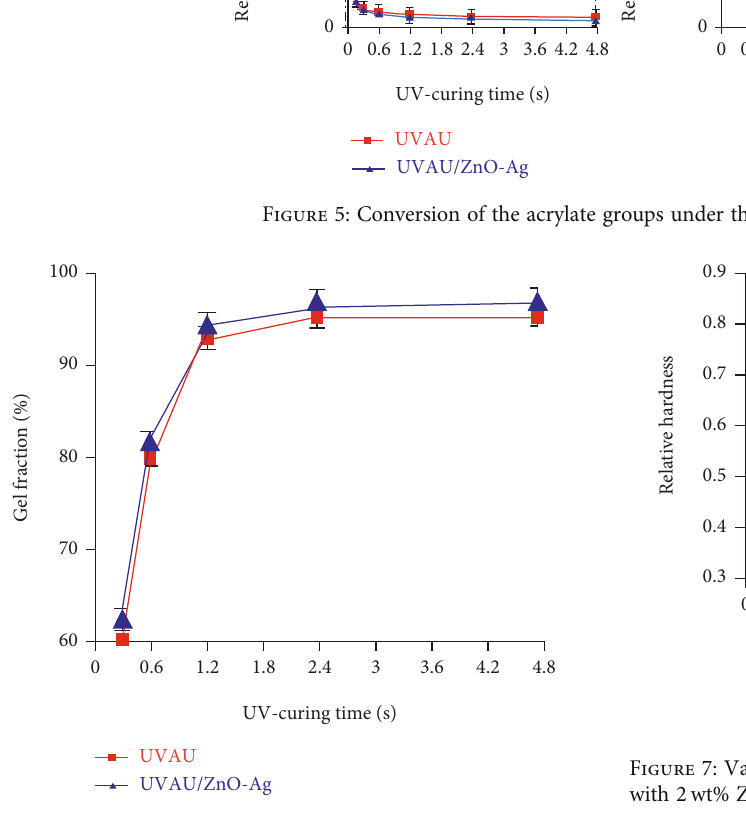
Figure 6: Variations of GEL of the photocurable acrylate urethane coating without (UVAU) and with 2wt% ZnO-Ag nanohybrids